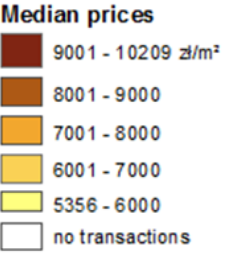
Fig. 4. Classification legend (source: own